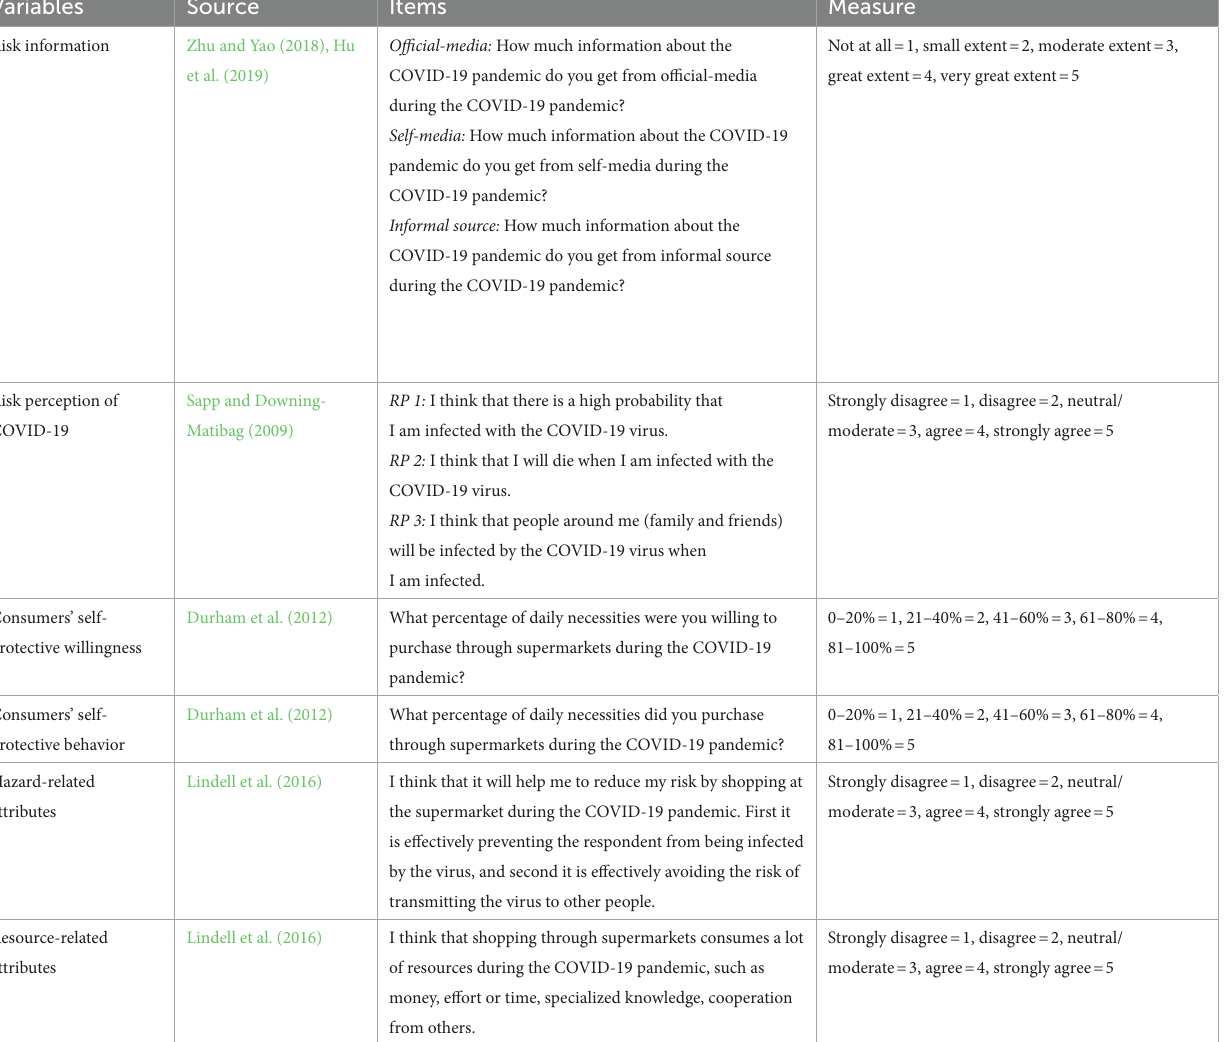
TABLE 2 Key variables and questionnaire